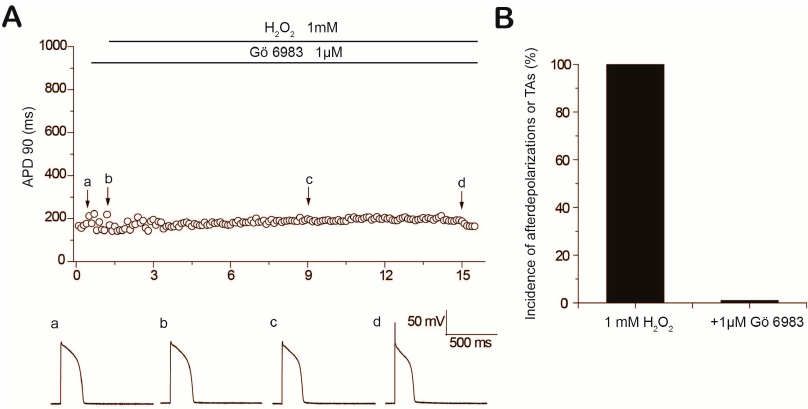
Figure 2. Prevention of H 2 O 2 -induced early afterdepolarizations (EADs) by the protein kinase C inhibitor Gö 6983. ( A ) Time course of action potential duration (APD) 90 in a myocyte treated with Gö 6983 before exposure to 1 mM H 2 O 2 . Action potentials under control conditions (a), in the presence of Gö 6983 (b); after perfusion of H 2 O 2 for 8 min (c) and 14 min (d) are shown below; ( B ) Incidence of EADs, delayed afterdepolarizations (DADs) or triggered activities (TAs) in the presence of H 2 O 2 and pretreated with Gö 6983.